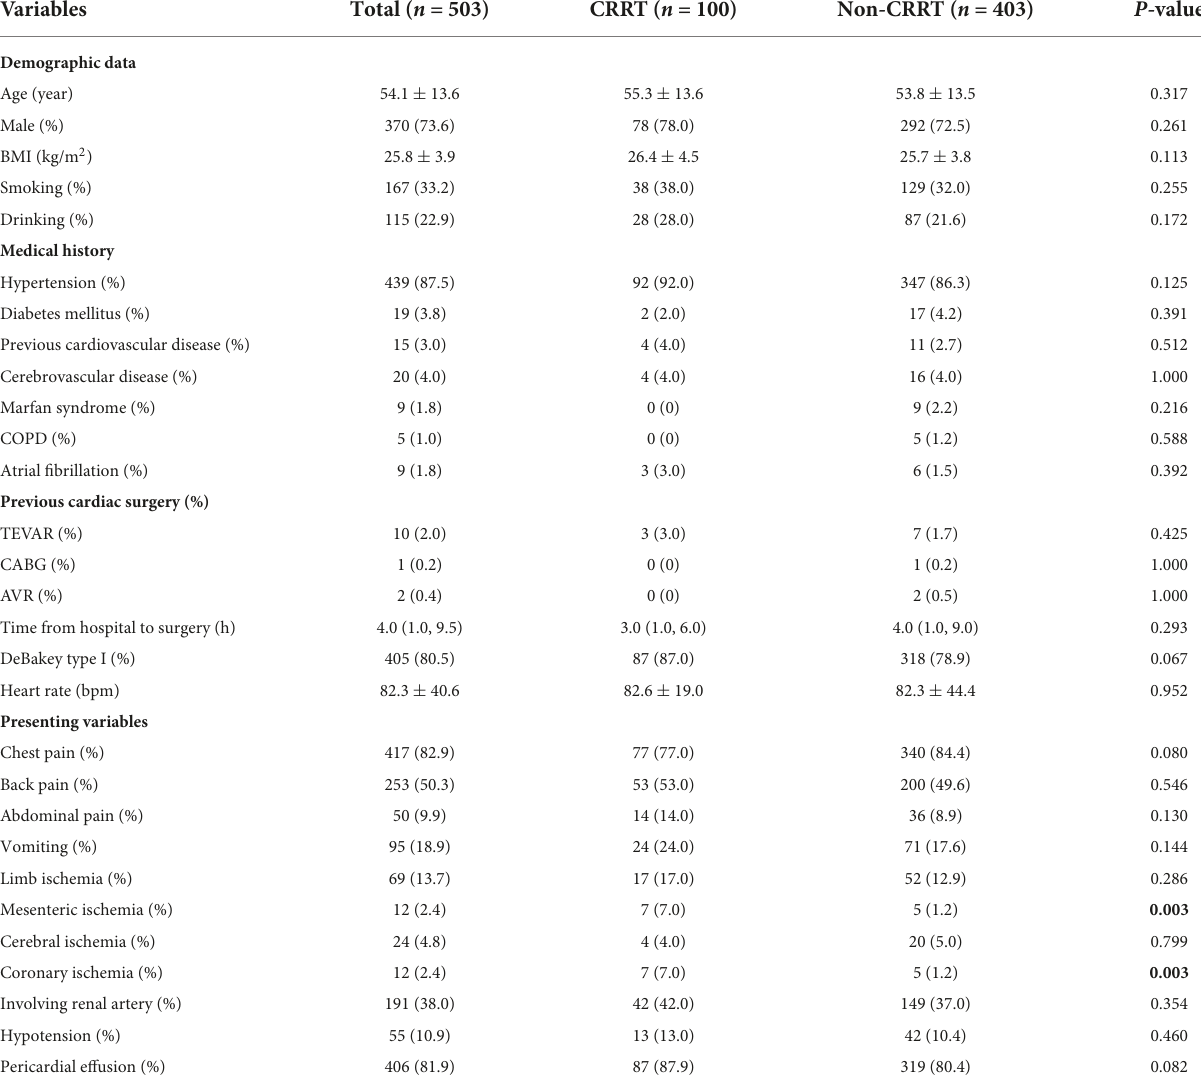
TABLE 1 Comparison of preoperative